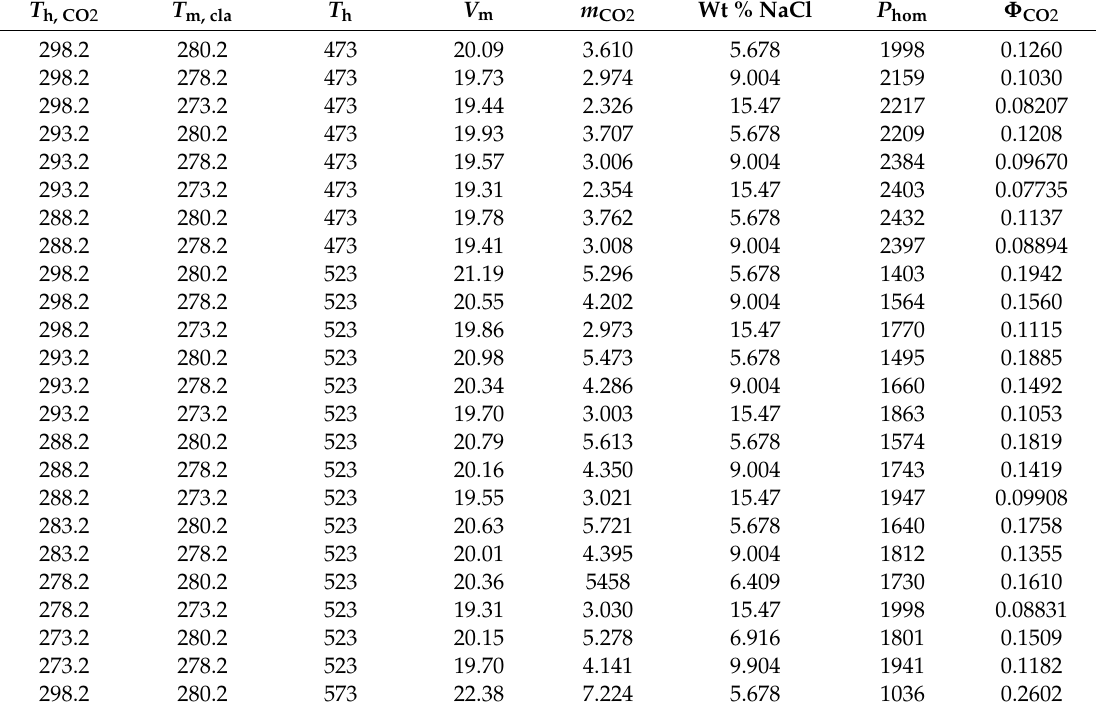
Table 4. Samples for V-x parameters of H 2 O–NaCl–CO 2 inclusions (liquid CO 2 + vapor CO 2 homogenized to liquid